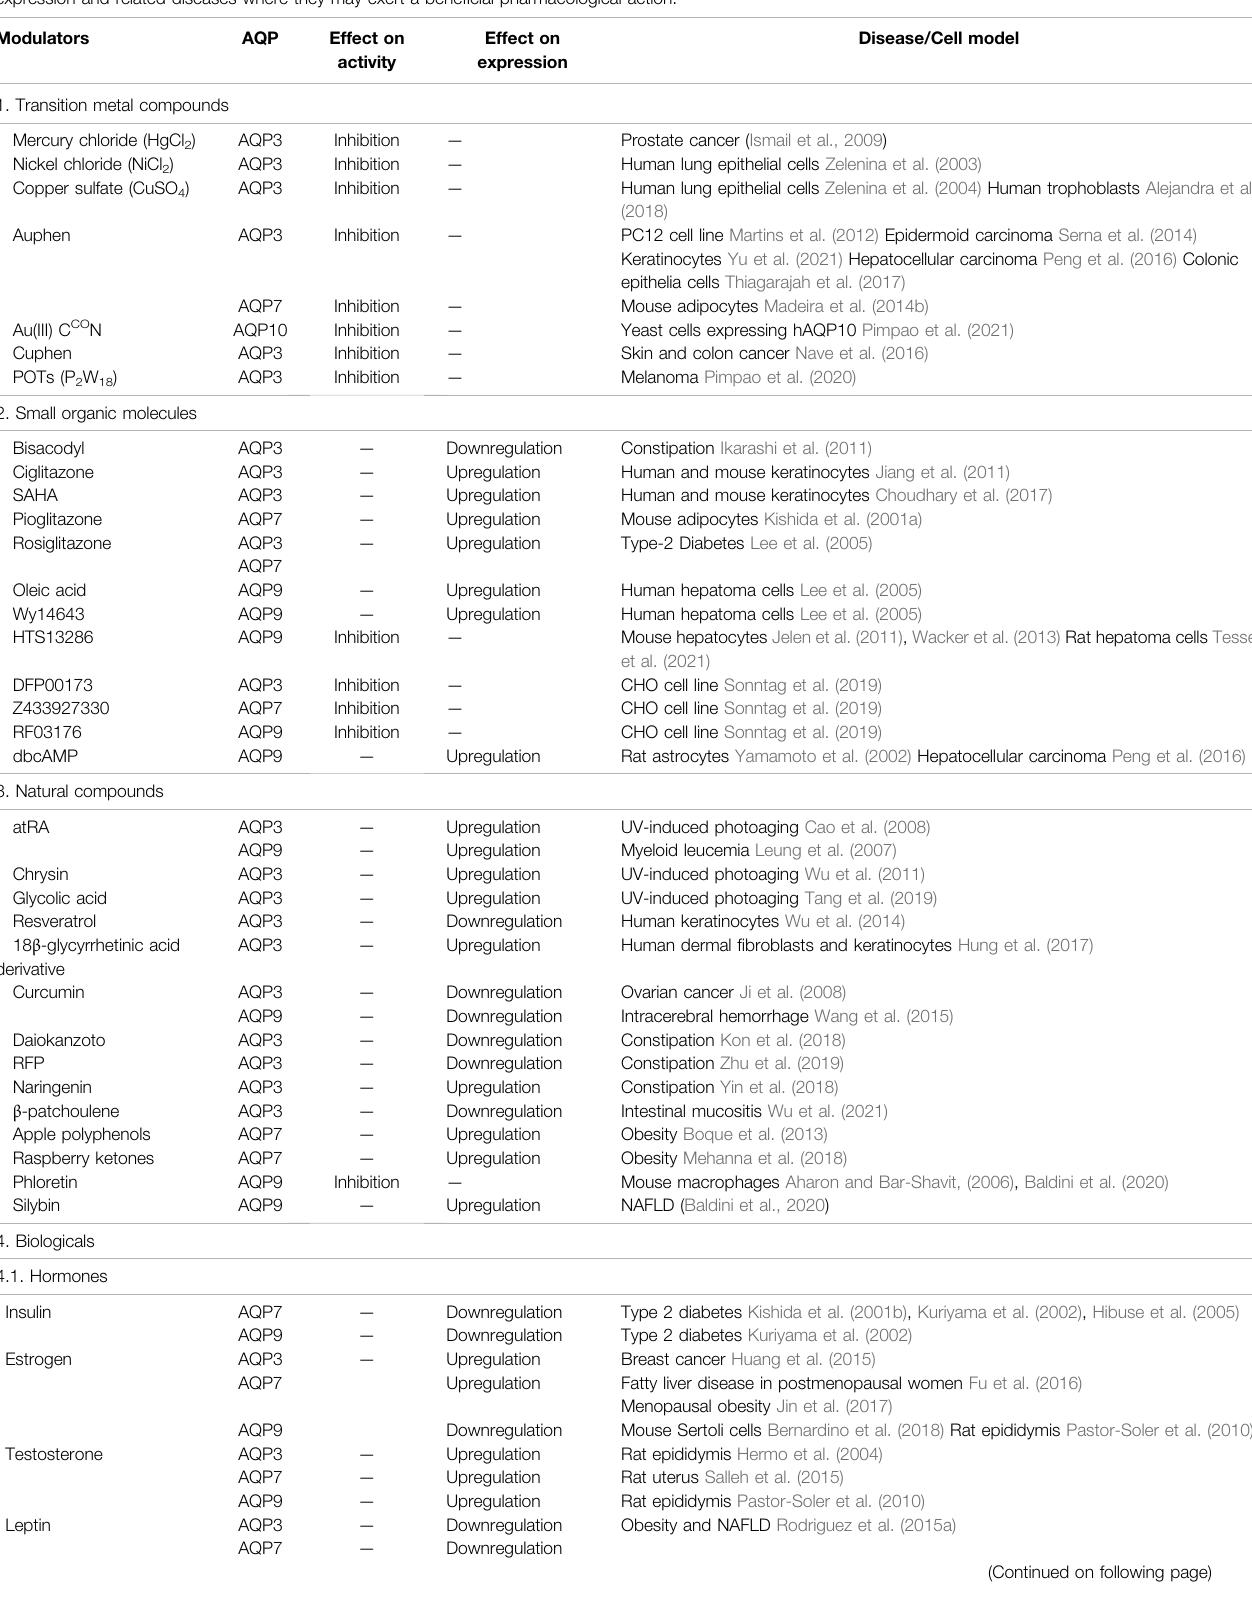
TABLE 1 | Classes of compounds (transition metal compounds, small molecules, natural compounds and biologicals) modulators of aquaglyceroporin function or expression and related diseases where they may exert a bene fi cial pharmacological